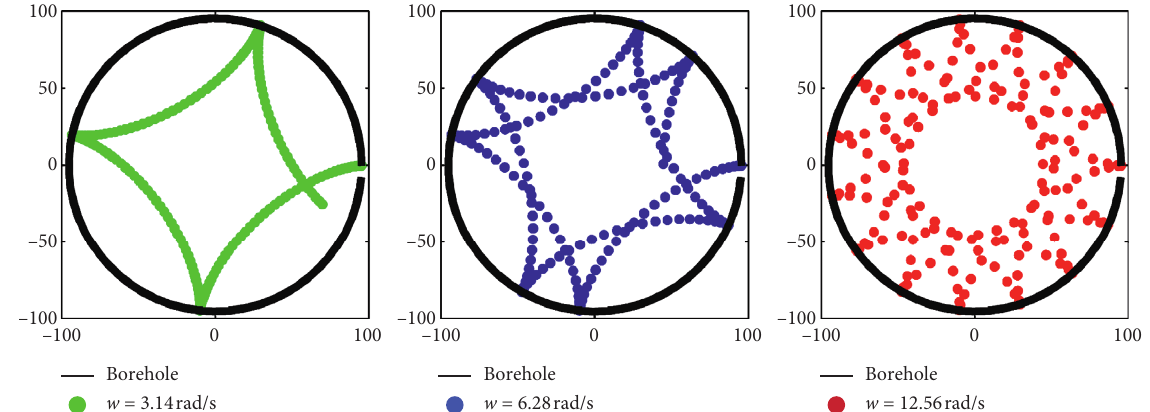
Figure 4: Schematic diagram of P -point trajectory when time t � 1-2 s.